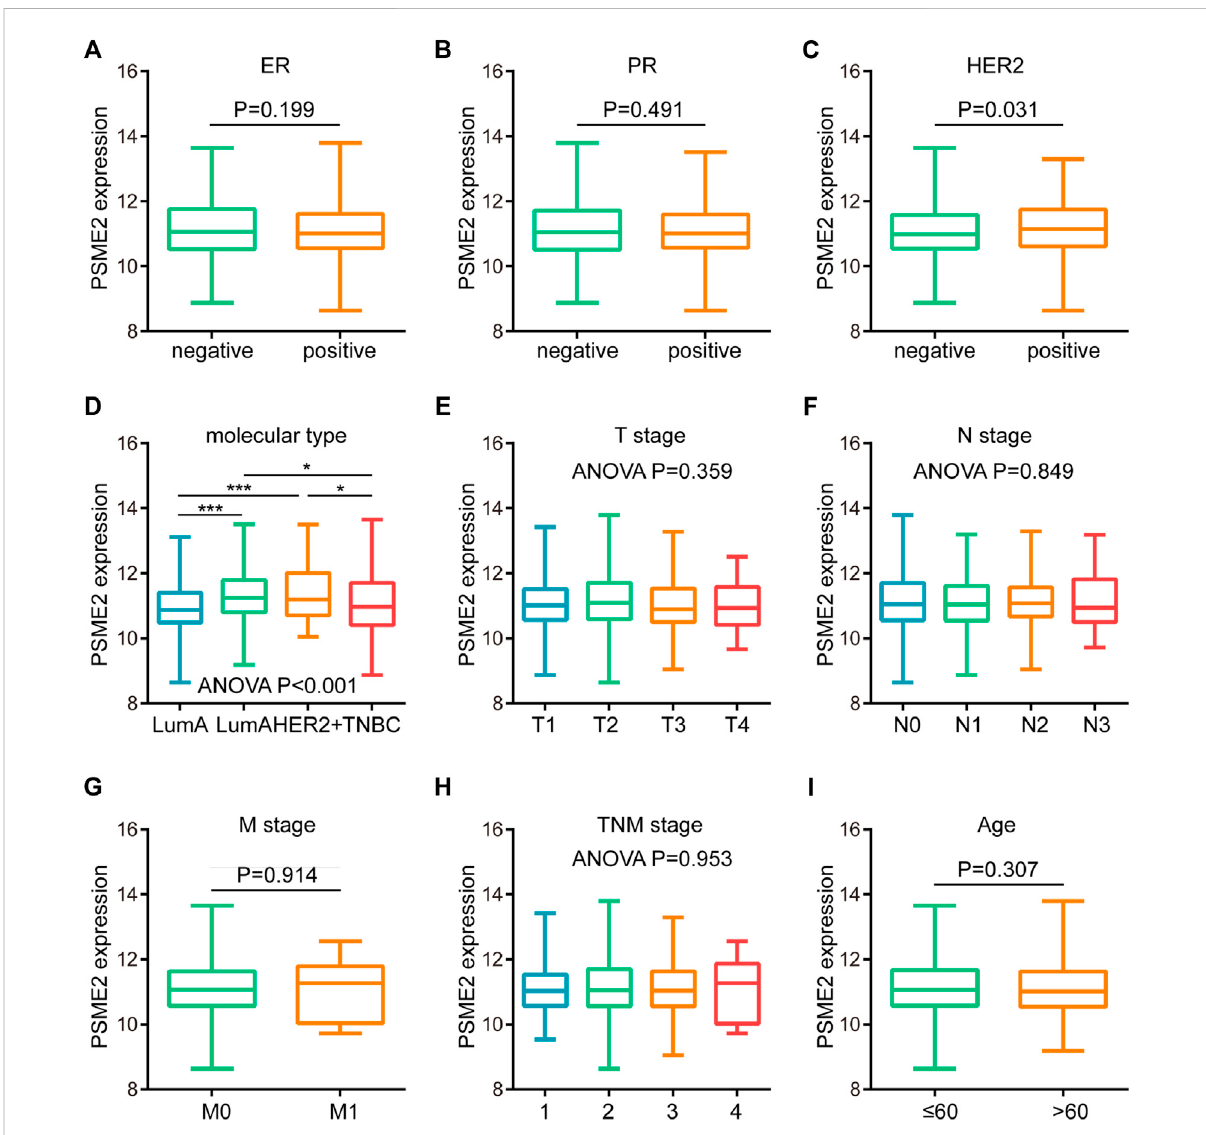
Associations between PSME2 and clinicopathological features in BrCa. Expression level of PSME2 in BrCa with different (A) ER (B) PR (C) HER2 status (D) molecular subtypes (E) T (F) N (G) M (H) clinical stages, and (I) ages. PSME2 expression was only associated with HER2 status